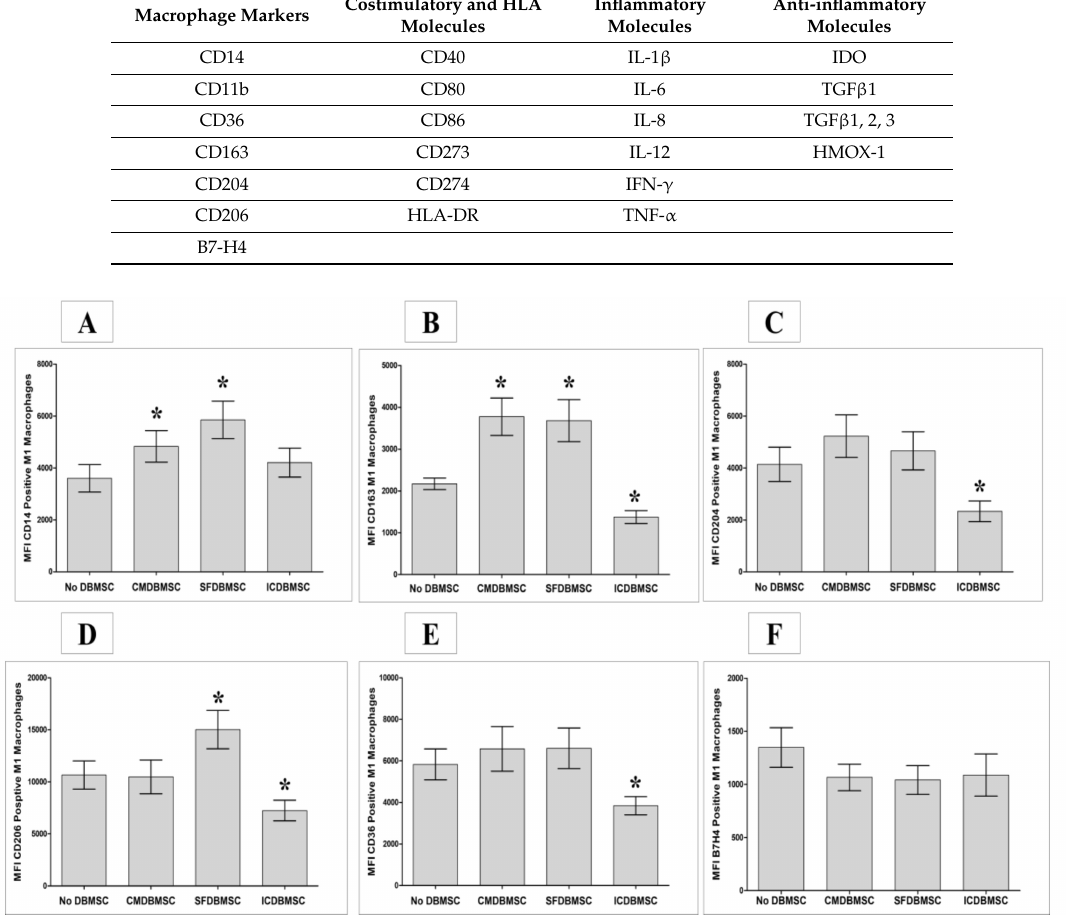
Figure 2. Effects of human DBMSCs on the expression of cell surface molecules CD14, CD163, CD204, CD206, CD36, and B7H4 on human monocytes differentiated into macrophages by GM-CSF, as analyzed by flow cytometry. After six days in culture, compared to untreated macrophages, CMDBMSCs significantly increased expression of CD14 ( A ) and CD163 ( B ) on macrophages while having no significant effect ( p > 0.05) on expression of CD204 ( C ), CD206 ( D ), CD36 ( E ), and B7H4 ( F ) on macrophages. Compared to untreated macrophages, SFDBMSC significantly increased expression of CD14 ( A ), CD163 ( B ), and CD206 ( D ) on macrophages while having no significant effects ( p > 0.05) on expression of CD204 ( C ), CD36 ( E ), and B7H4 ( F ) on macrophages. In addition, ICDBMSCs significantly decreased expression of CD163 ( B ), CD204 ( C ), CD206 ( D ) and CD36 ( E ) on macrophages while having no significant effects ( p > 0.05) on expression of CD14 ( A ) and B7H7 ( F ) compared with that on untreated macrophages. Levels of expression are presented as median fluorescent intensity (MFI) as determined by flow cytometry. Experiments were carried out in duplicate and repeated 30 times using 30 individual preparations of both monocyte-derived macrophages and DBMSCs. * p < 0.05. Bars represent standard